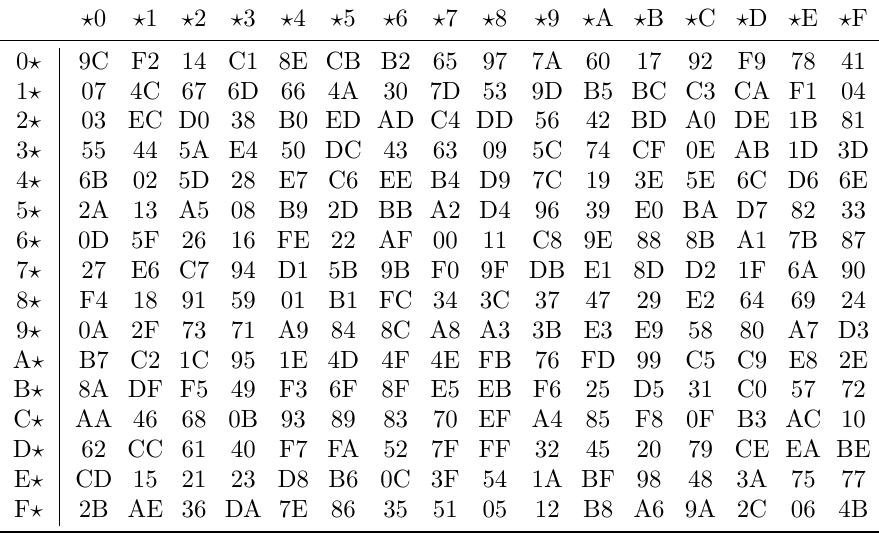
Table 2: The SoDark S-box. Adapted from